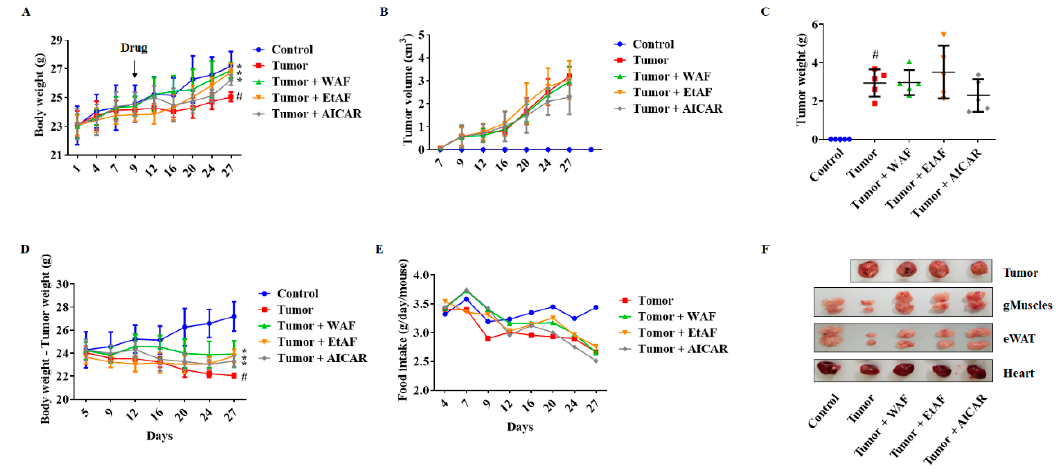
Figure 2. Effects of AF on the cachectic symptom in CT-26 tumor-bearing mice. CT-26 cells were subcutaneously injected into the abdominal area of mice ( n = 5). 100 mg / kg / day of WAF and EtAF were orally administrated every day, and 250 mg / kg of 5-aminoimidazole-4-carboxamide-1- β -D-ribofuranoside (AICAR)wasintraperitoneallyinjectedevery 2 days. AICAR was used as a positive control. Weight changes for 27 days ( A ) and tumor volume changes ( B ) were measured on the indicated day. The tumor weights were measured after sacrificing the mice ( C ). Body weight-tumor weight ( D ) and food intake ( E ) were measured on the indicated day. The representative images of the tumor, gMuscle, eWAT, and heart were captured ( F ). AICAR was used as a positive control. All values are mean ± SD. # p < 0.05, significantly different from control group; * p < 0.05, significantly different from tumor group.